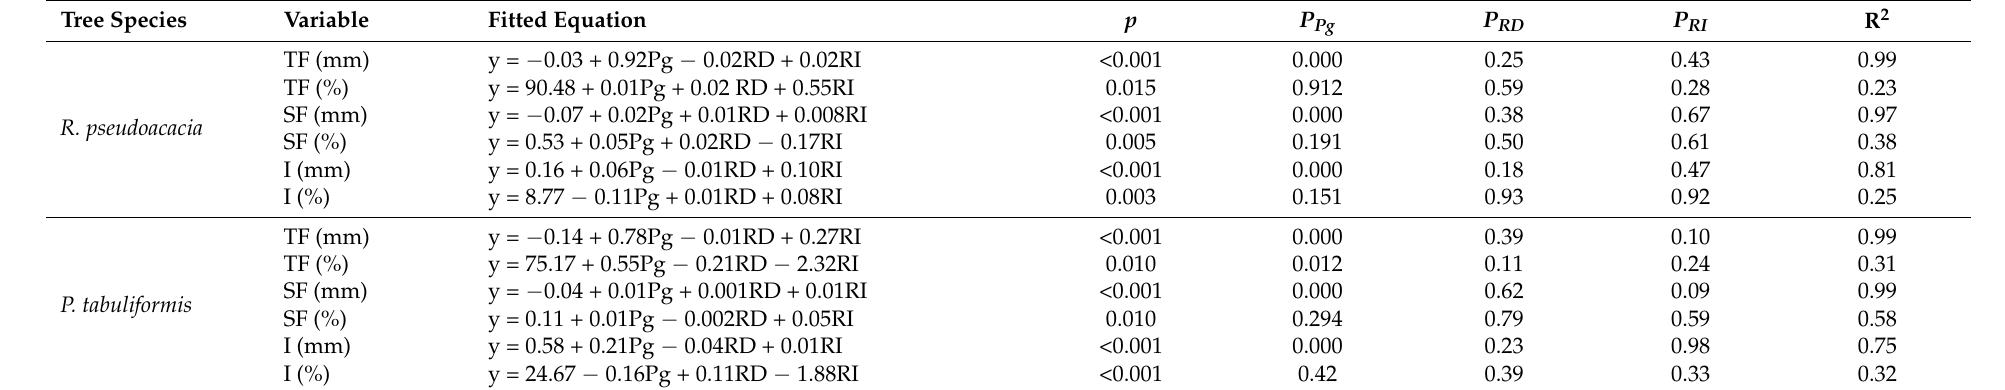
Table 4. Results of multiple line regression analysis of rainfall partitioning components with rainfall characteristics for R. pseudoacacia and P. tabuliformis forest stands during the dormant season in